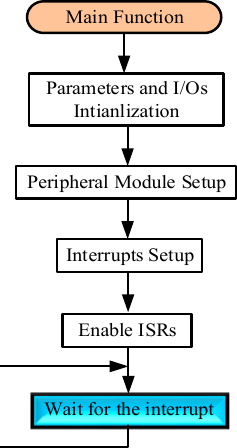
Figure 9. Main function flowchart of the DSP-based microcontroller system.